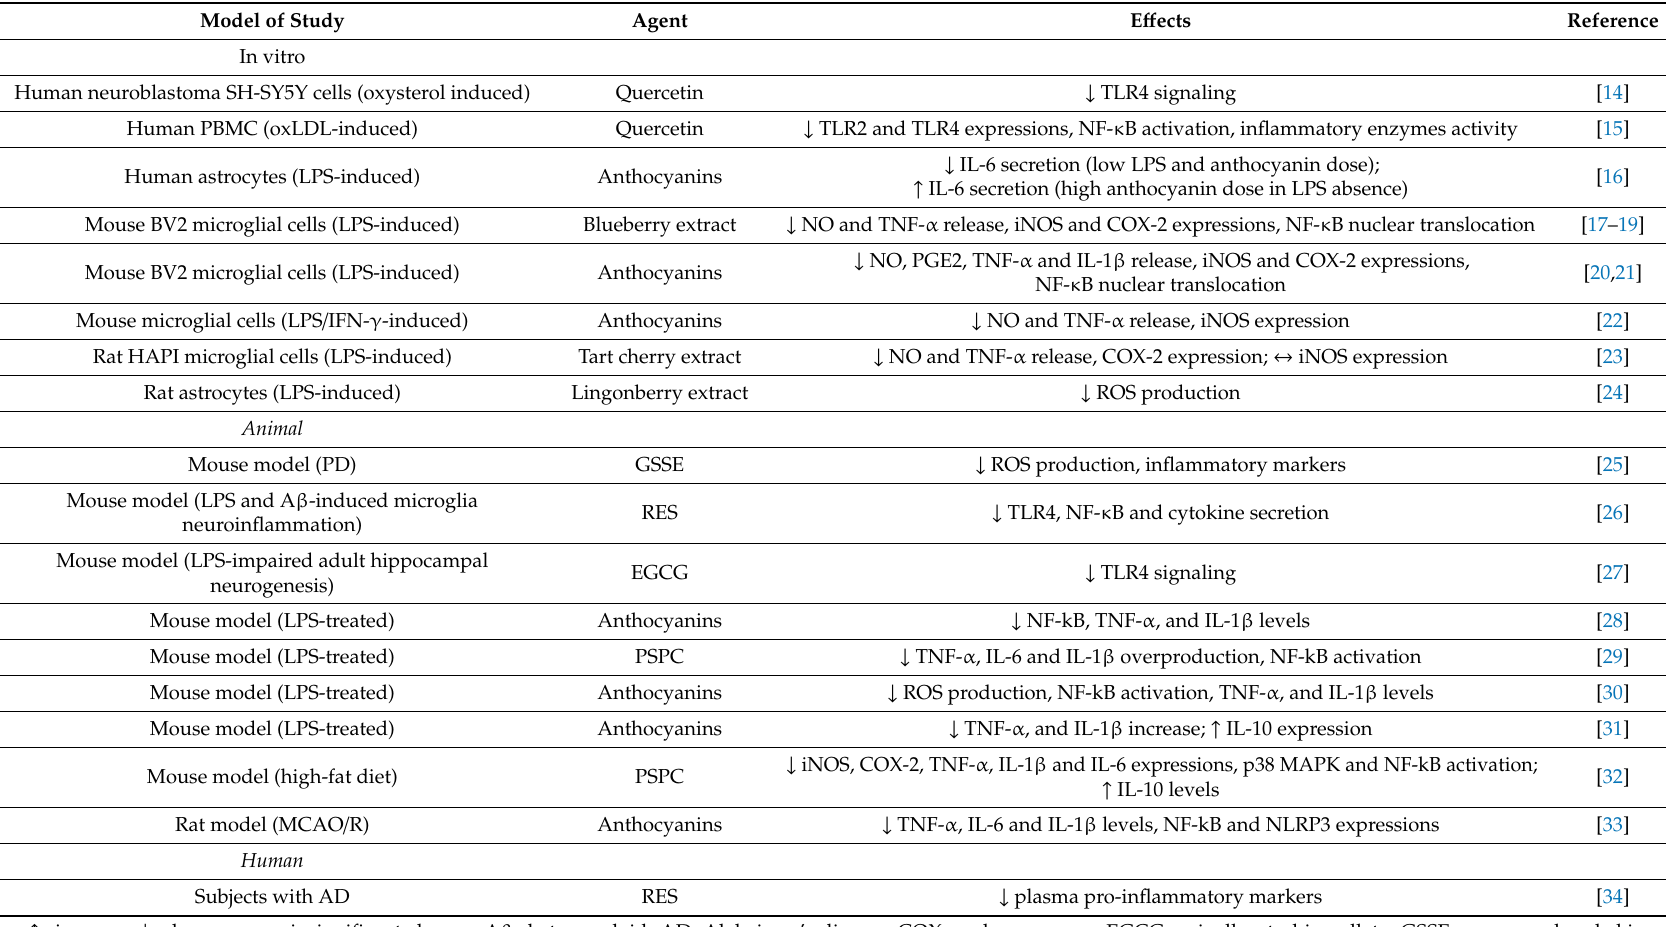
Table 1. Summary of the e ff ects of polyphenols on brain inflammation in the last 15 years